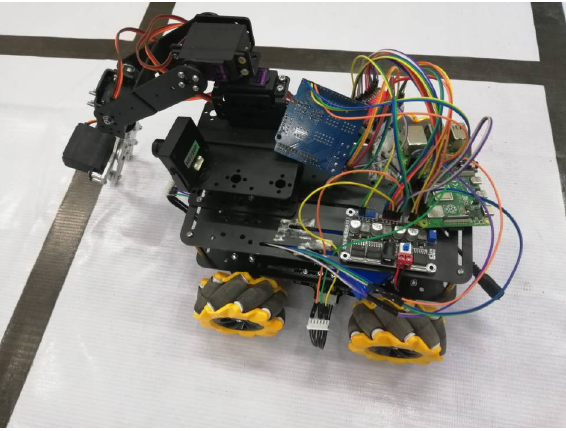
Figure 2. Photograph of the assembled